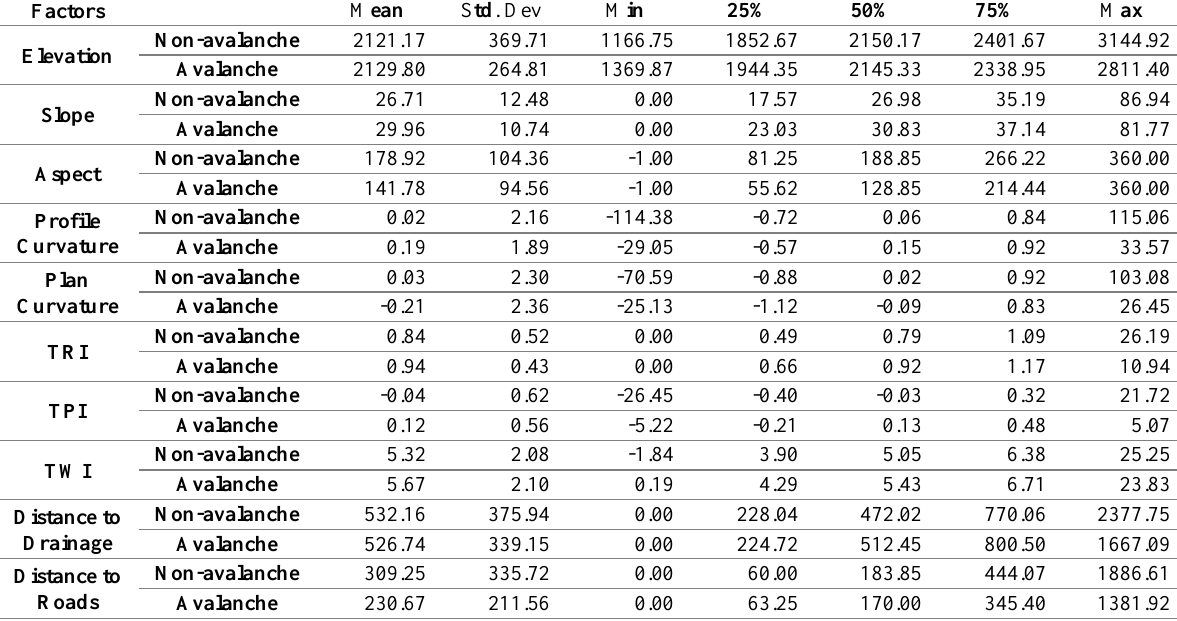
Table 2. Summary statistics of the numerical features. The RF is a tree-based ensemble learning algorithm, that was first proposed by Breiman (2001) and is widely used for classification and regression problems. The method creates trees from randomly selected data with the bootstrap technique. The sklearn.